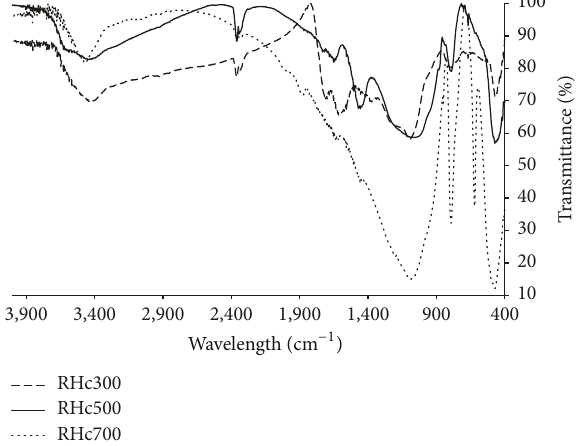
Figure5:IRspectrumofRHc300(dashedline),RHc500(solidline), and RHc700 (dotted line) samples.